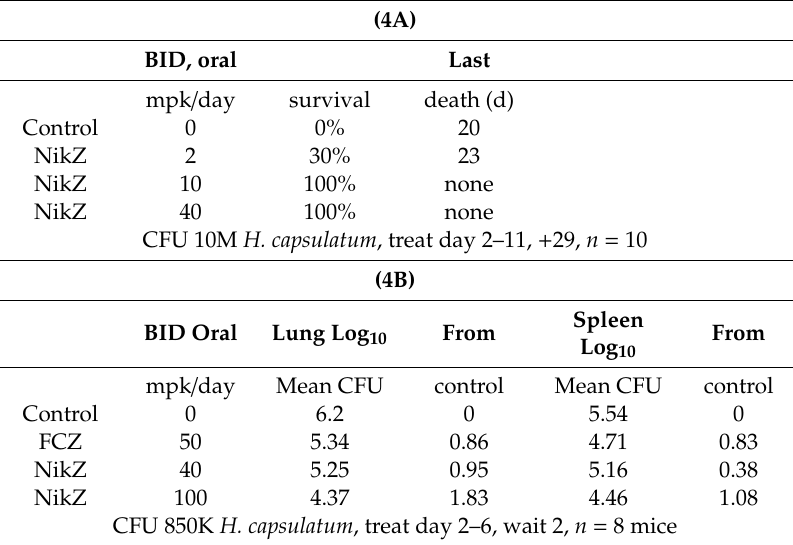
Table 4. IV disseminated histoplasmosis ( 4A ) survival, ( 4B ) organ burden [34]. (4A)